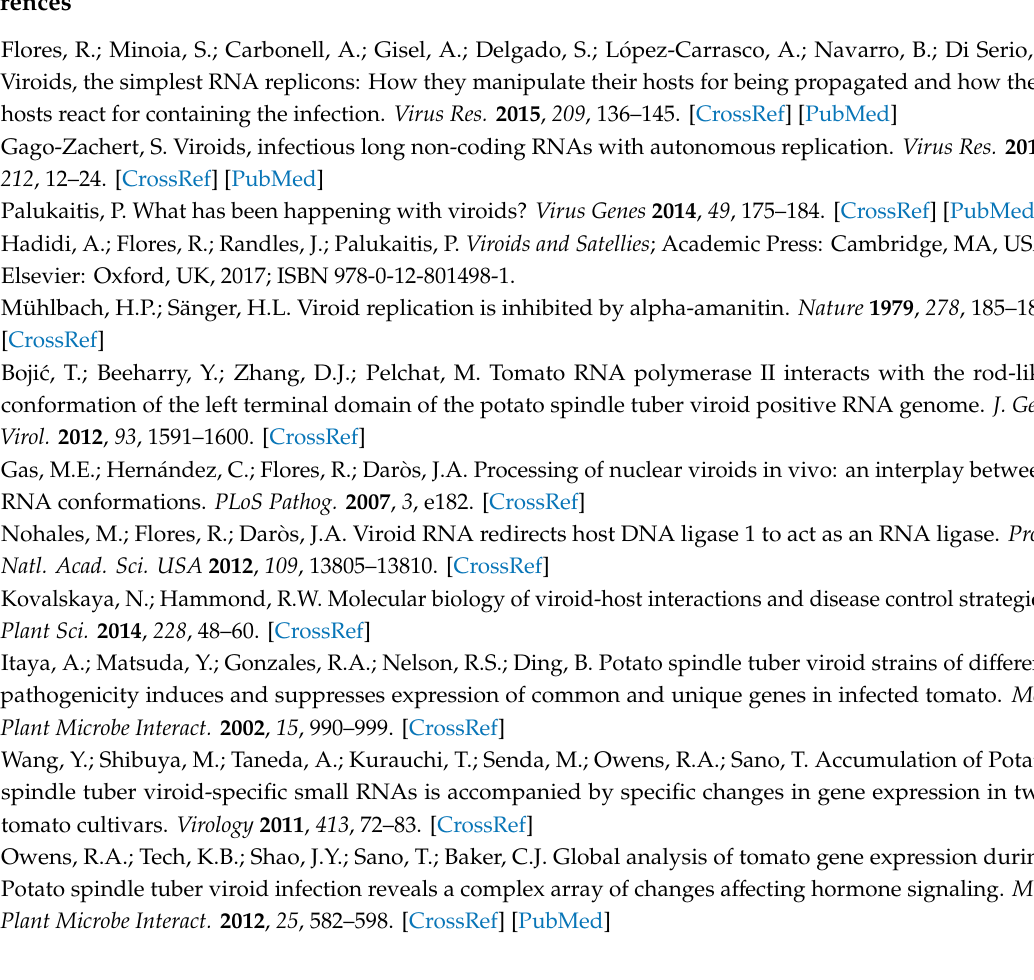
Figure S1: Correlation of microarray and RNA-seq data for DEGs identified in microarray. Table S1: Probes used in the NanoString nCounter gene expression analysis. Table S2. Tomato DEGs identified in PSTVd-M- and PSTVd-S23-infected roots by microarray. Table S3. Summary of sequencing libraries. Table S4. List of DEGs identified from RNA-seq analysis after tomato infection with PSTVd M and S23 variants at 17 dpi. Table S5. KEGG pathway enrichment of DEGs from microarray analysis. Table S6. All enriched GO terms in the BP category for the down-and up-regulated DEGs (from microarray analysis) at the indicated infection time point. Table S7. All enriched GO terms in the BP category for the all down-and up-regulated DEGs (from RNA-seq analysis) by M and S23 variants, and for DEGs exclusively regulated by only one PSTVd variant. Table S8. Di ff erentially regulated hormone-related genes identified by microarray and RNA-seq. Table S9. Di ff erentially regulated genes encoding TFs and PKs identified by microarray and RNA-seq. Table S10. Di ff erentially regulated cell-wall-related genes identified by microarray and RNA-seq. Table S11. Di ff erentially regulated lignin-related genes identified by microarray and RNA-seq. Table S12. Di ff erentially regulated proteasome-related